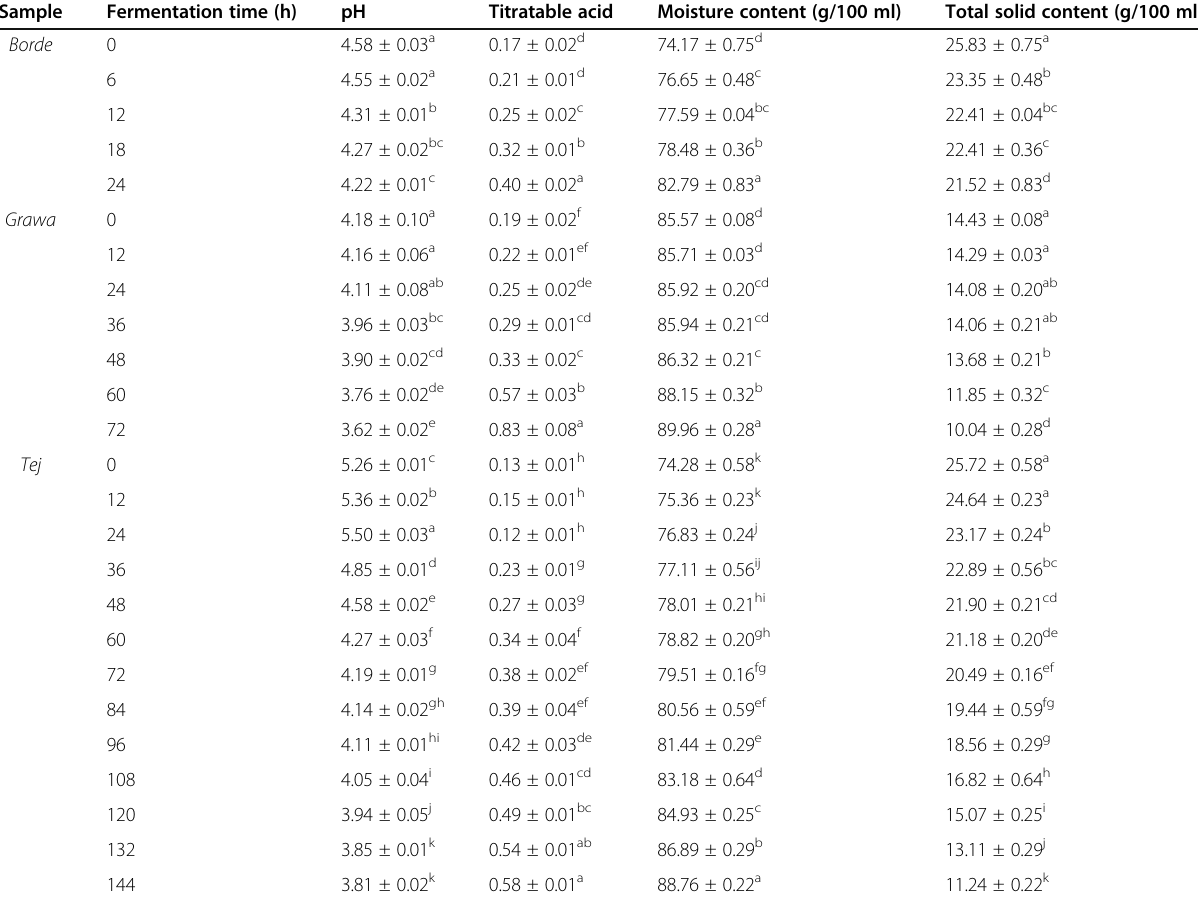
Table 2 Some physicochemical characteristics (mean ± SD) during laboratory-scale fermentation of selected beverages